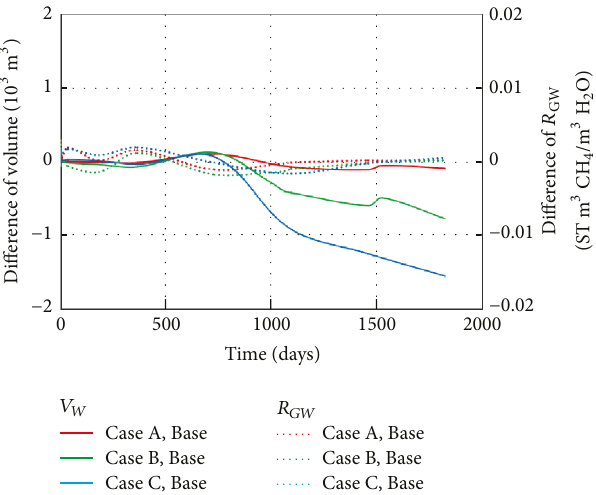
Figure 12: The difference of the cumulative volume of water produced at the well ( 𝑉 𝑊 ) and gas-to-water ratio ( 𝑅 𝐺𝑊 ) between horizontal strata and those sloping formations over 5-year produc- tion